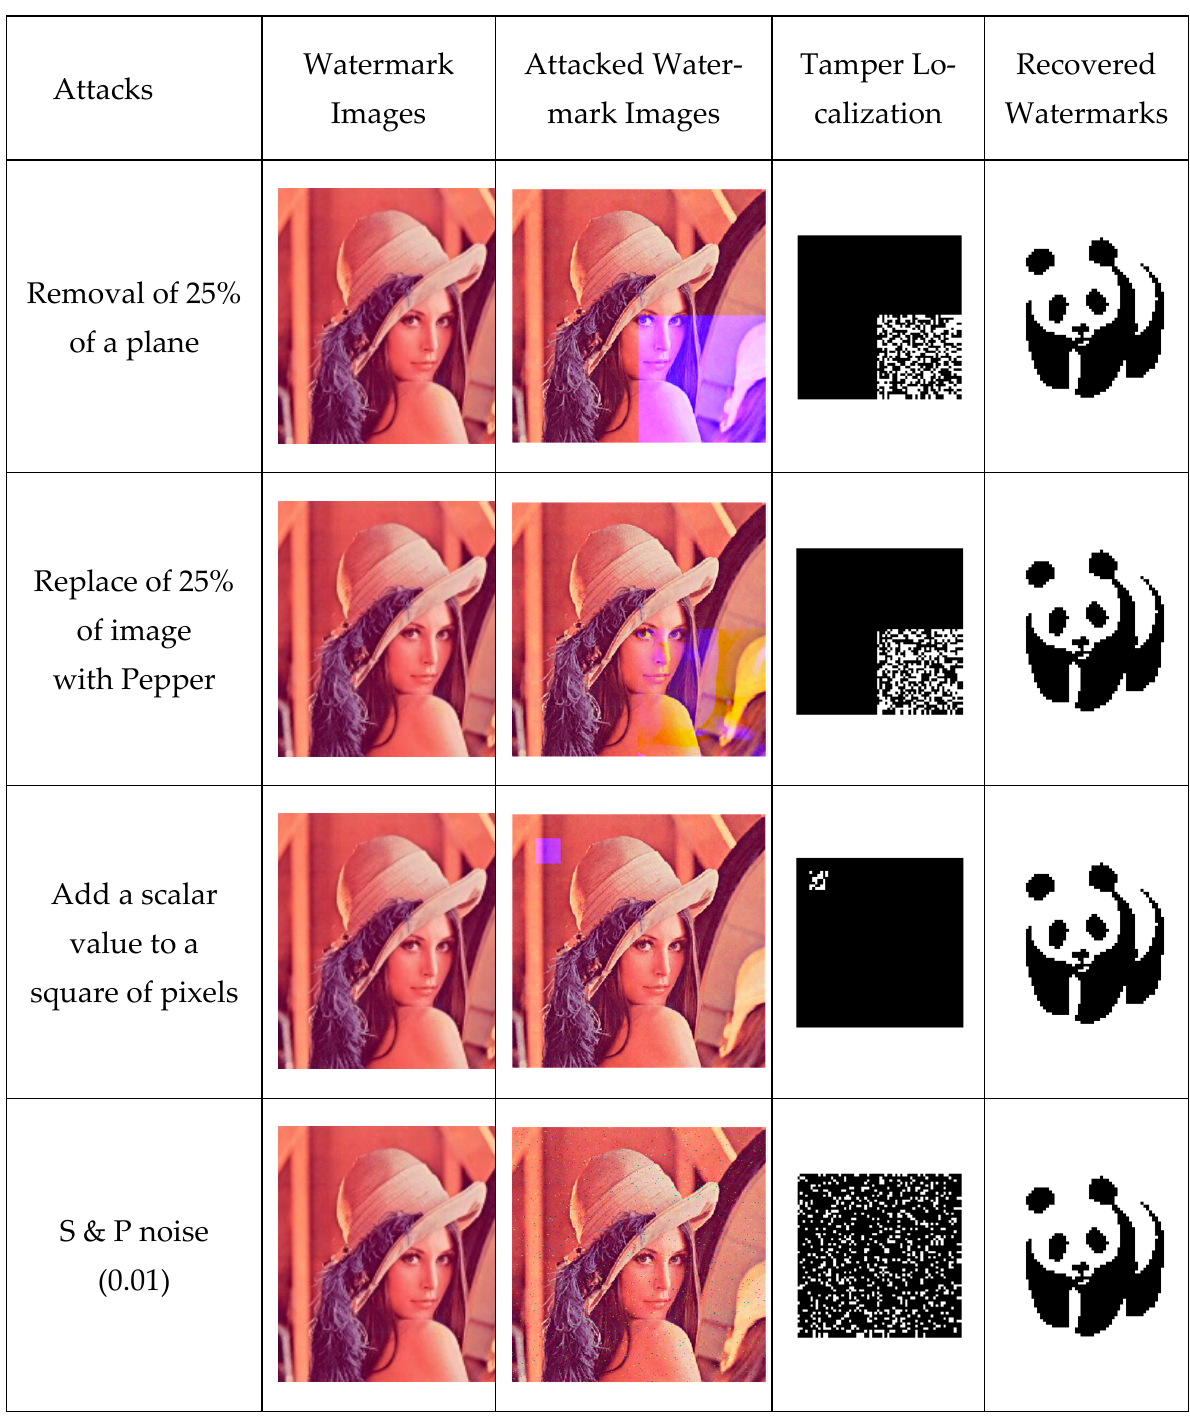
Figure 16. Tampering location and recovery robust watermark under some single a tt acks.